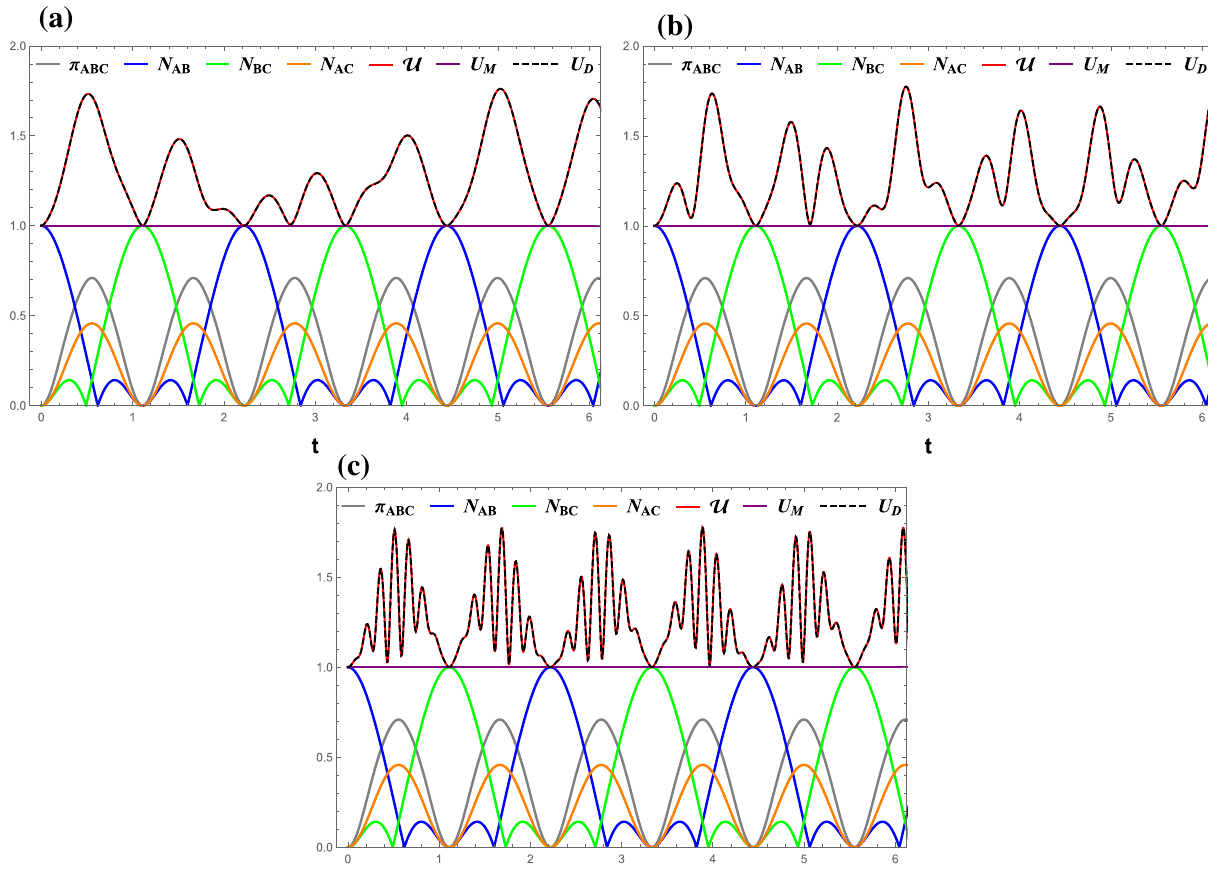
Figure 2. (Color online) Time evolutions of U (red line), U M (purple line), U D (black dashed), π ABC (gray line), N AB (blue line), N BC (green line), and N AC (orange line) under the measurement ( σ x , σ z ). ( a ) B = 1, ( b ) B = 3, and ( c ) B = 10. All Figs. γ = 0, J z =